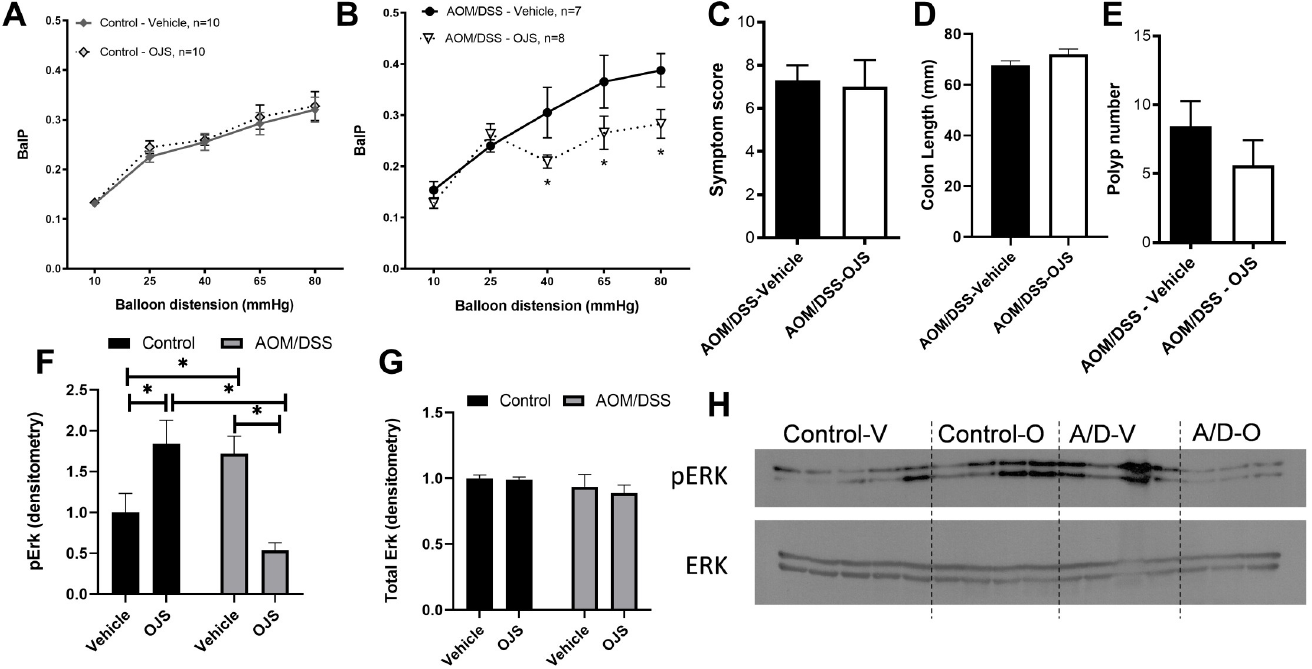
Fig 3. OJS reduces visceral pain-related intracolonic pressure during ascending phasic distensions in AOM/DSS mice. Each colorectal distension (CRD, 10, 25, 40, 65, and 80 mmHg) included a 20 sec duration followed by a 5 min interval between distensions and each distension was repeated 3 times. (A) Control non-cancer mice and (B) AOM/DSS mice were orally gavaged with Vehicle (water) or OJS (2000 mg/kg dissolved in water) 10 min prior to the initiation of CRD. � Indicates statistical significance (p < 0.05) from a two-way RM ANOVA Fisher LSD, n = 10 in non-cancer (control) groups, and n = 7–8 in AOM/DSS groups. (C) Symptom score, (D) colon length, and (E) polyp number were assessed in AOM/DSS-Vehicle and AOM/DSS-OJS mice. Spinal cord protein expression of (F) phosphorylated and (G) total Erk and (H) blot images. � Indicates statistical significance (p < 0.05) from two-way ANOVA Fisher LSD, n = 4–5 in non-cancer (control) groups, and n = 3–4 in AOM/DSS groups.